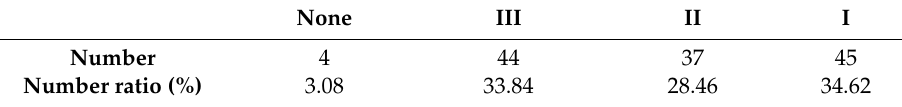
Table 4. The level of land occupation and destruction of cities in